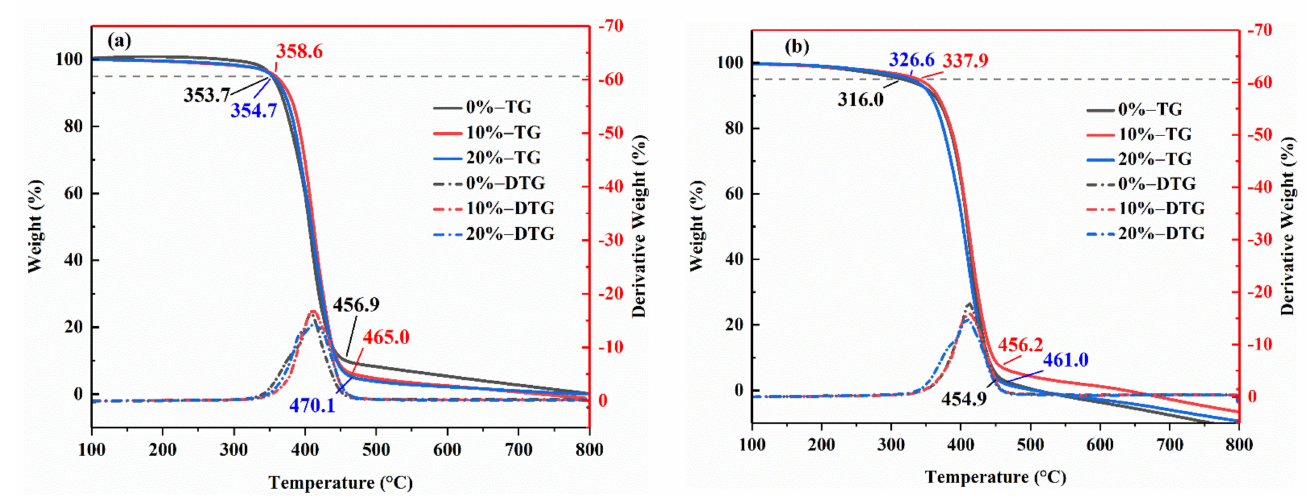
Figure 8. TG and DTG curves of various resin systems under different aging conditions ( a ) Without aging ( b ) After salt